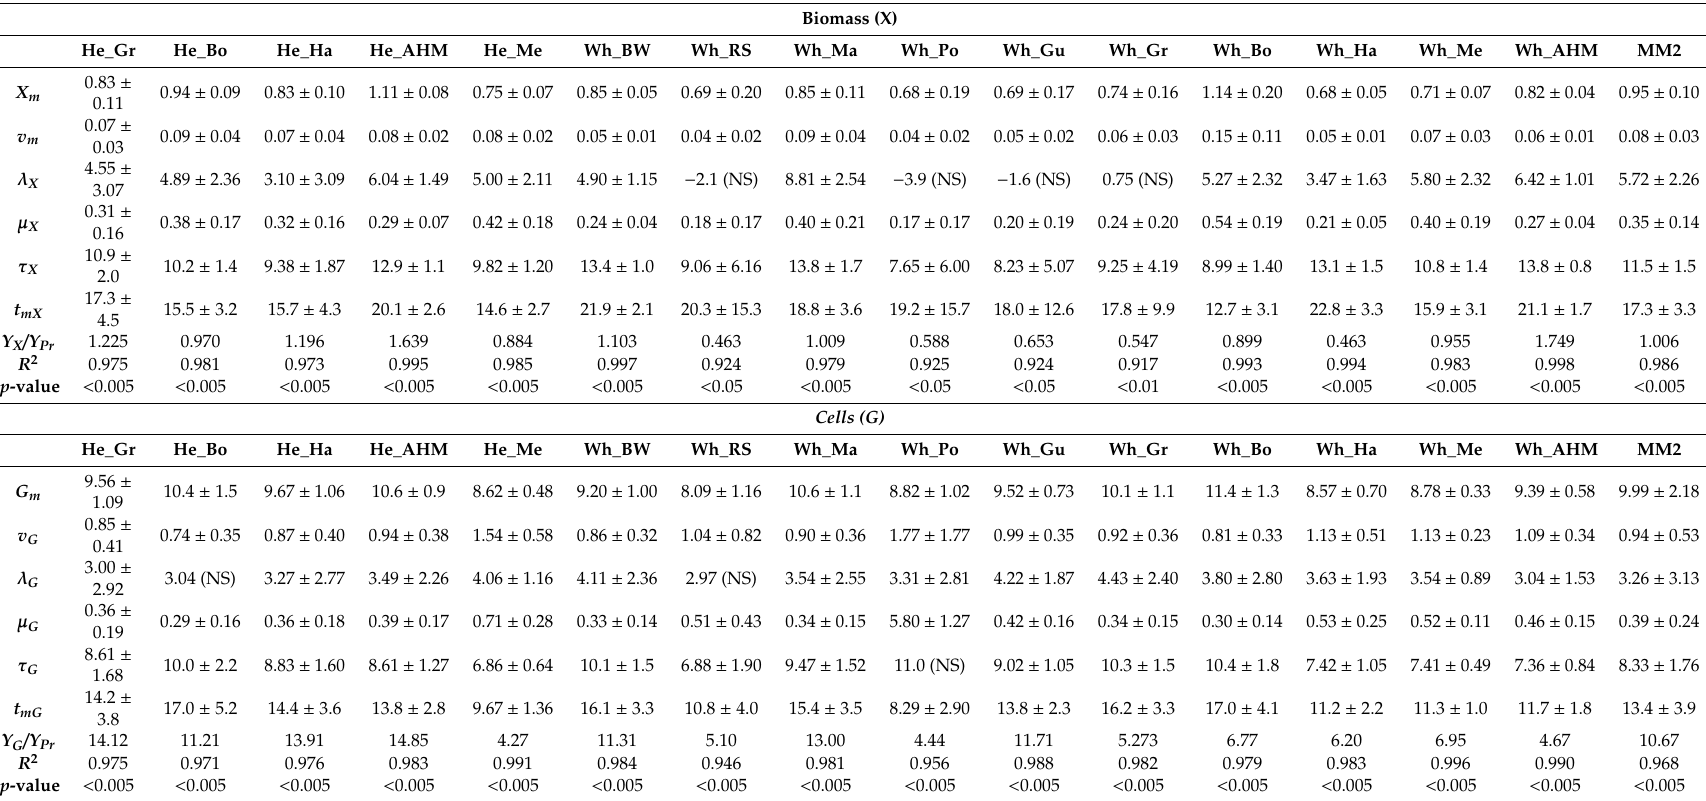
Table 2. Continuation of Table